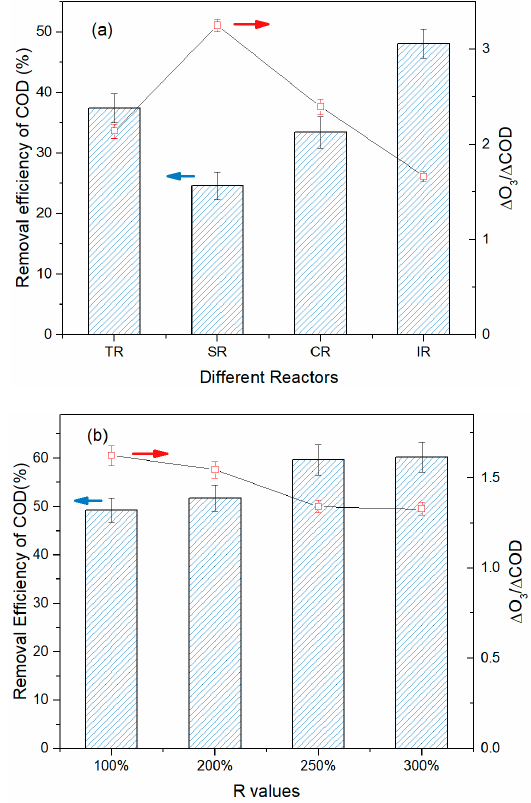
Figure 7. The effect of ( a ) different reactors and ( b ) circulation flow ratios (experimental conditions: Figure 7. The e ff ect of ( a ) di ff erent reactors and ( b ) circulation flow ratios (experimental conditions: pH, 8.5 ± 0.3; catalyst dosage, 180 g ∙ L − 1 ; ozone dosage, 80 mg ∙ L − 1 ∙ h − 1 ; COD of influent, ~150 mg ∙ L − 1 , pH, 8.5 ± 0.3; catalyst dosage, 180 g · L − 1 ; ozone dosage, 80 mg · L − 1 · h − 1 ; COD of influent, ~150 mg · L − 1 , hydraulic retention time, 90 min). hydraulic retention time, 90